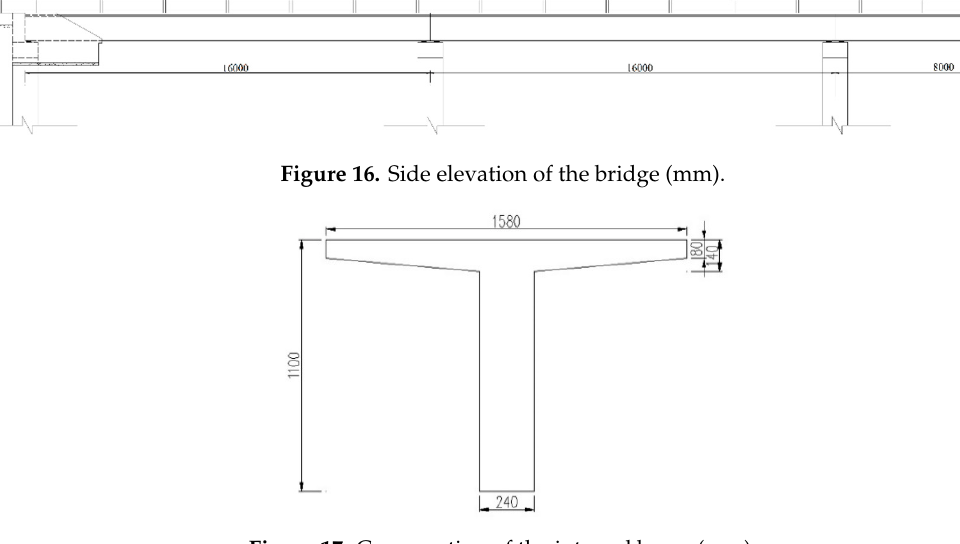
Figure 17. Cross section of the internal beam (mm).